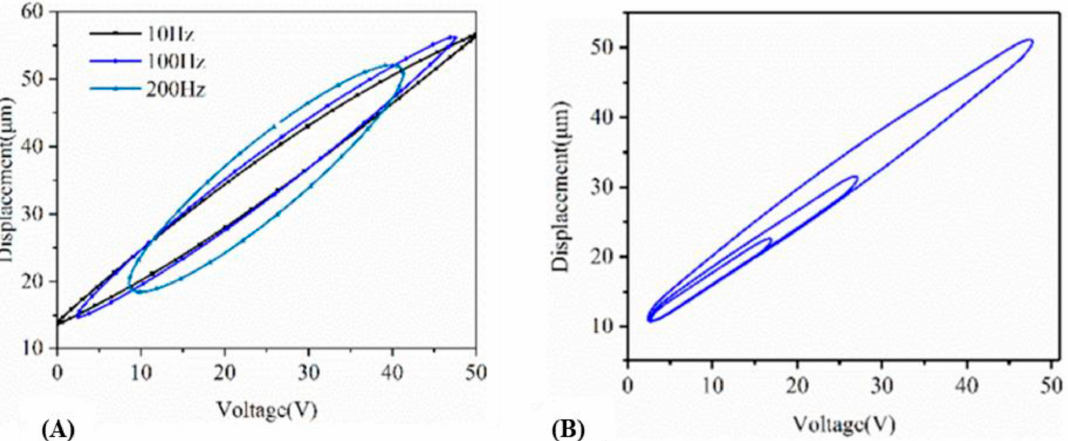
Figure 22. Each hysteresis loop consists of both piezoelectric events, retraction and extension. For the same input voltage, the displacements for retraction are always greater than when extended. ( A ) Effect of frequency variation on hysteresis effect; ( B ) Hysteresis under sinusoidal loading of constant frequency, varying amplitude (right)